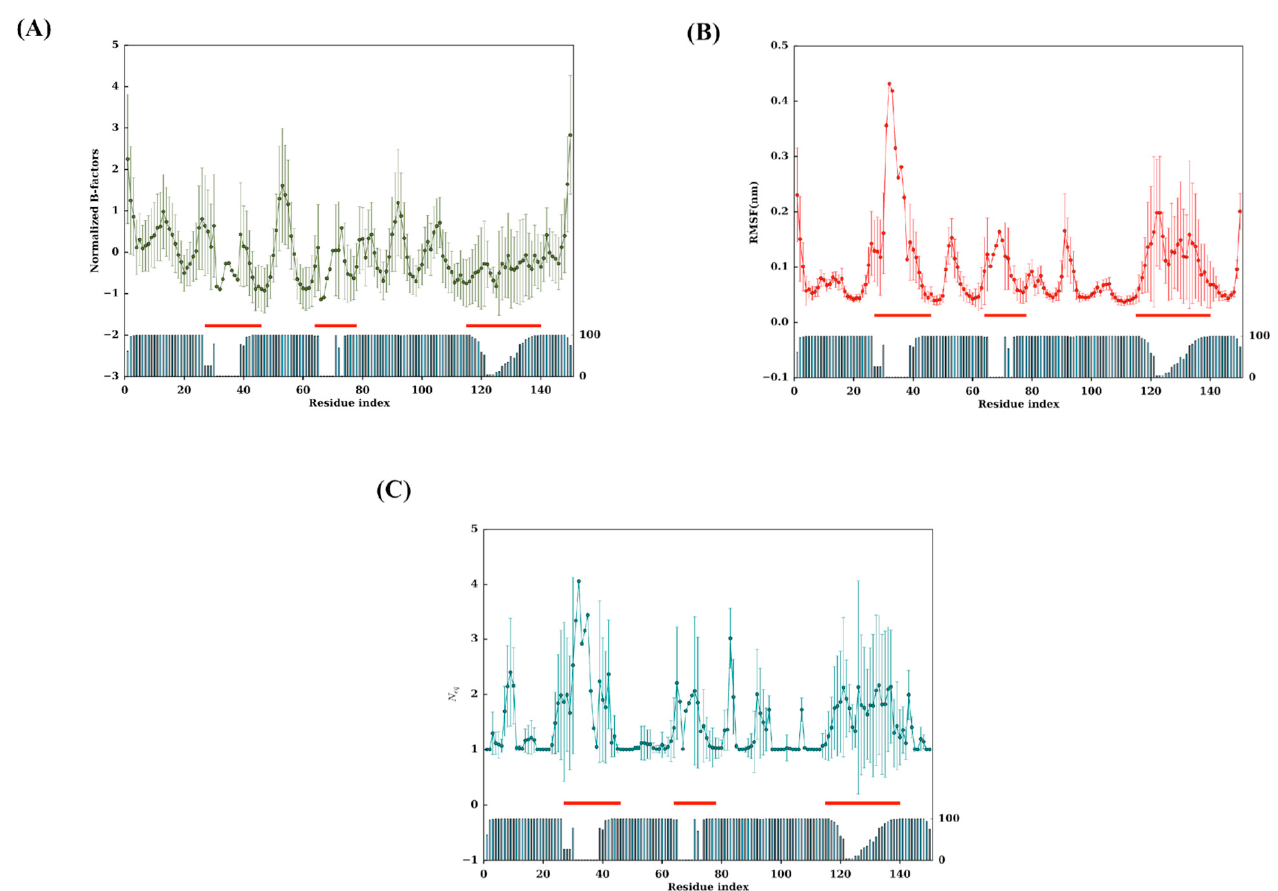
Figure 3. Tendencies of flexibility metrics at each residue position. Mean and standard deviation of ( A ) normalised C α B-factors, ( B ) C α RMSF and ( C ) N eq . Occurrence is shown as a histogram. CDR positions are shown as ref lines.